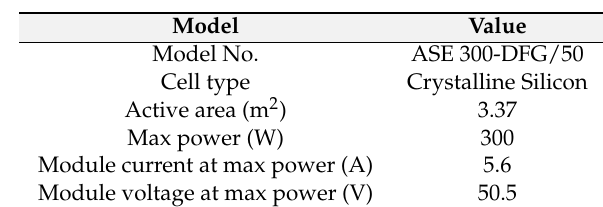
Table 2. Description of PV